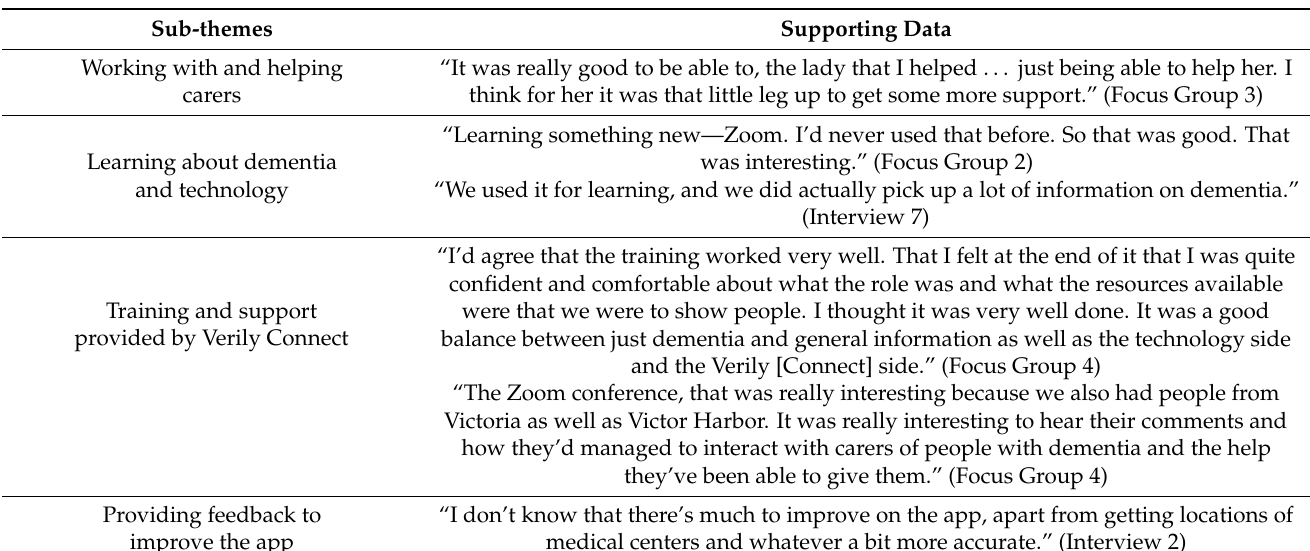
Table 1. Benefits of being a Verily Connect volunteer.